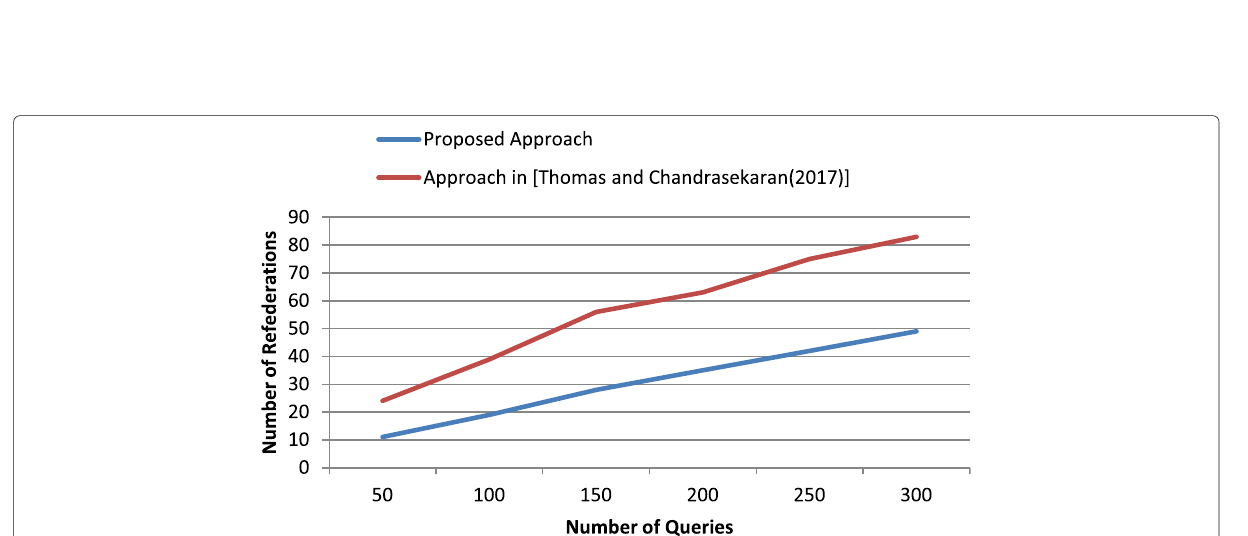
Fig. 12 Re-federation requests in case of [19] and proposed